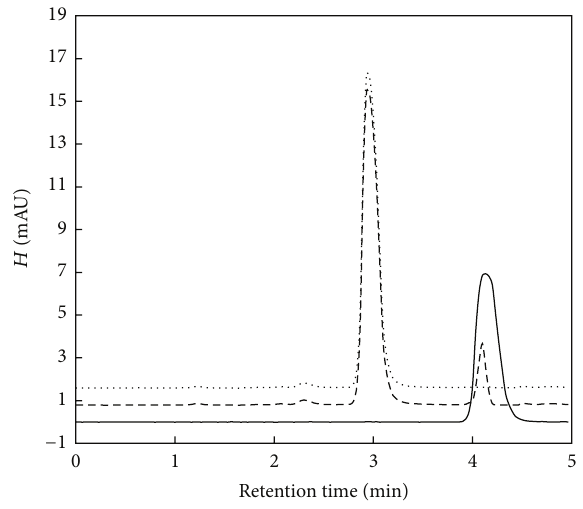
Figure 6: HPLC chromatograms of p -HBA before (—), after 1min (–––), and 2 min (- - -) reaction with the hydroxyl radicals. Reaction conditions: concentration of H 2 O 2 , 0.03%, Fe 2+ , 1mM, and ascorbic acid, 0.1mM. Chromatographic conditions: column, Eurospher C18 5 𝜇 m 250 × 4 mm I.D. (Knauer), temperature, 25 ∘ C, mobile phase, phosphate buffer pH = 6.6 with 2vol.% methanol, flow rate, 1mLmin −1 , and fluorescence detection with the excitation/emission wavelengths, 270/358 nm.